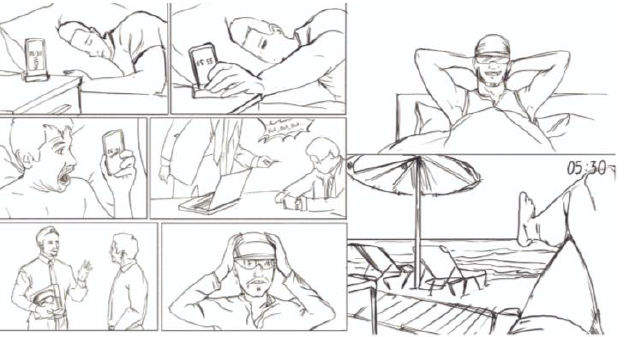
Figure 6. An example of a sketched storyboard for the alarm clock project.